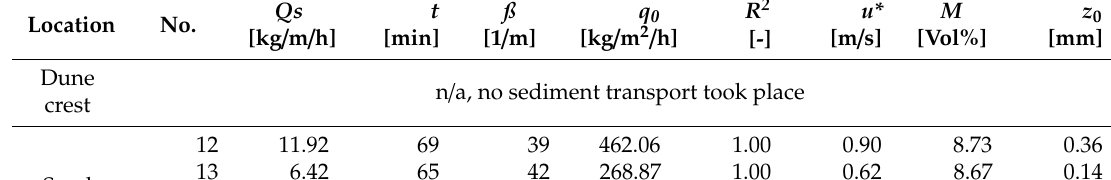
Sand trapping fence 2 Sand too little sediment transport to conduct regression analysis, no vertical wind profile according to trapping fence 3